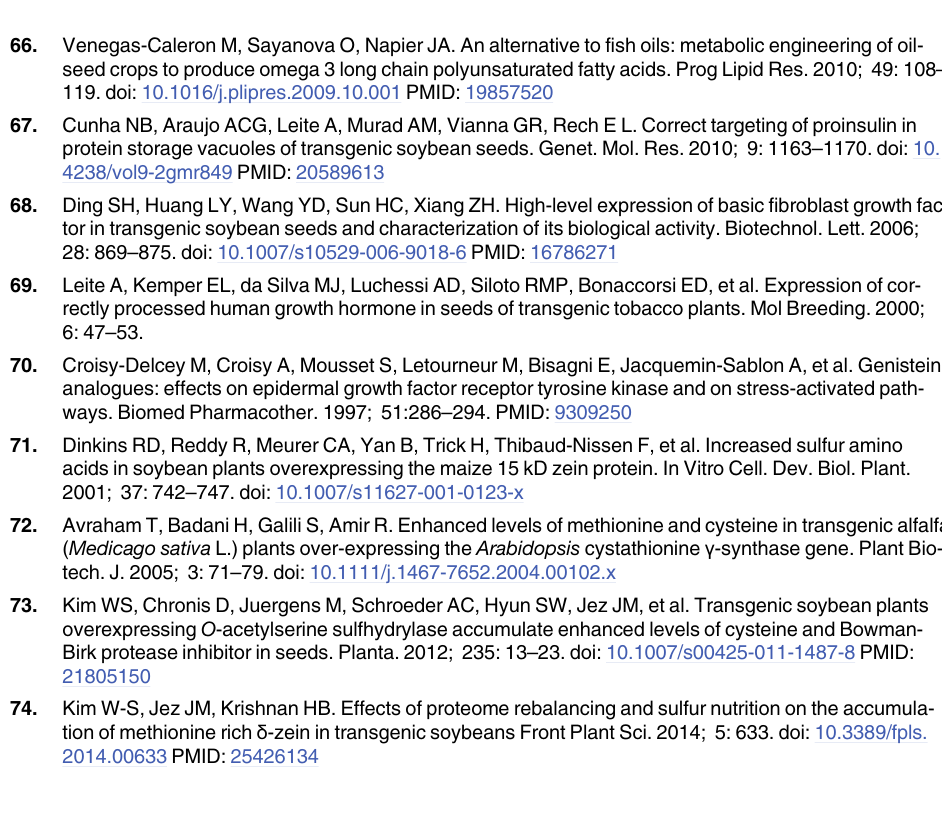
PLOS ONE | DOI:10.1371/journal.pone.0157034 June 17,